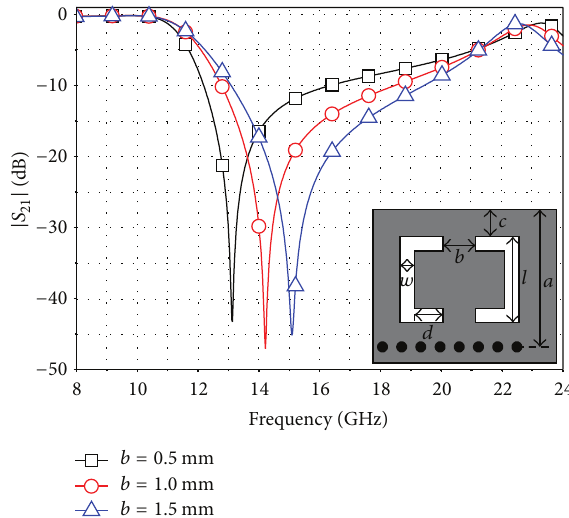
Figure 4: Simulated results of proposed HMSIW-DGS cell with different “ b .” Other geometrical parameters are 𝑎 = 7 mm, 𝑐 = 1 mm, 𝑤 = 0.5 mm, 𝑑 = 1 mm, and 𝑙 = 4.5